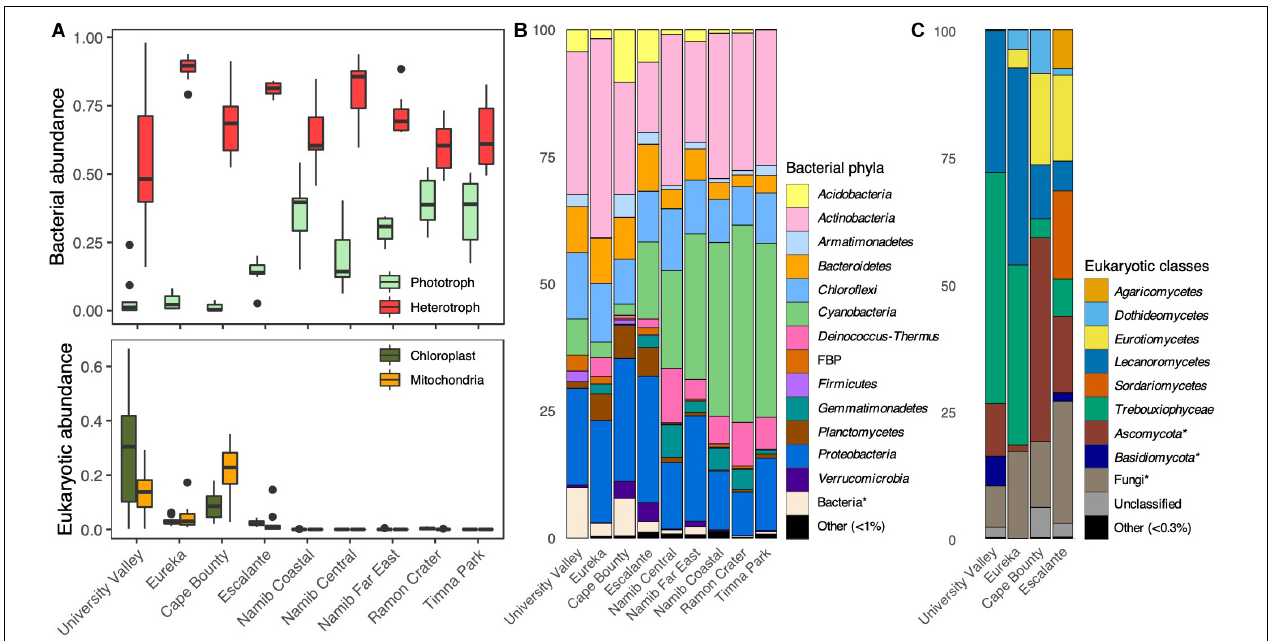
FIGURE 3 | Sandstone endolithic community composition. (A) Top: Relative proportions of bacterial phototrophs (oxygenic and anoxygenic phototrophs) and heterotrophs, obtained from 16S rRNA gene sequences Bottom: Relative proportions of chloroplast and mitochondrial 16S rRNA gene sequences. (B) Prokaryotic community composition, based on 16S rRNA gene sequences. (C) Eukaryotic community composition based on ITS sequences. Asterisks indicate a lack of taxonomic information up to the designated